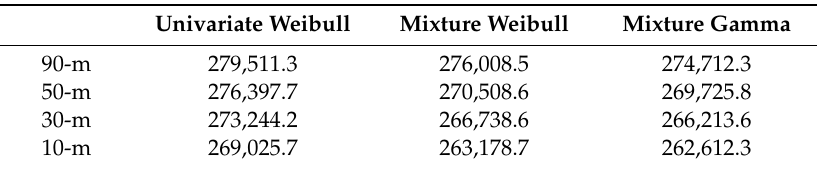
Table 3. The Akaike information criterion (AIC) values of di ff erent distribution models for wind speed data at di ff erent